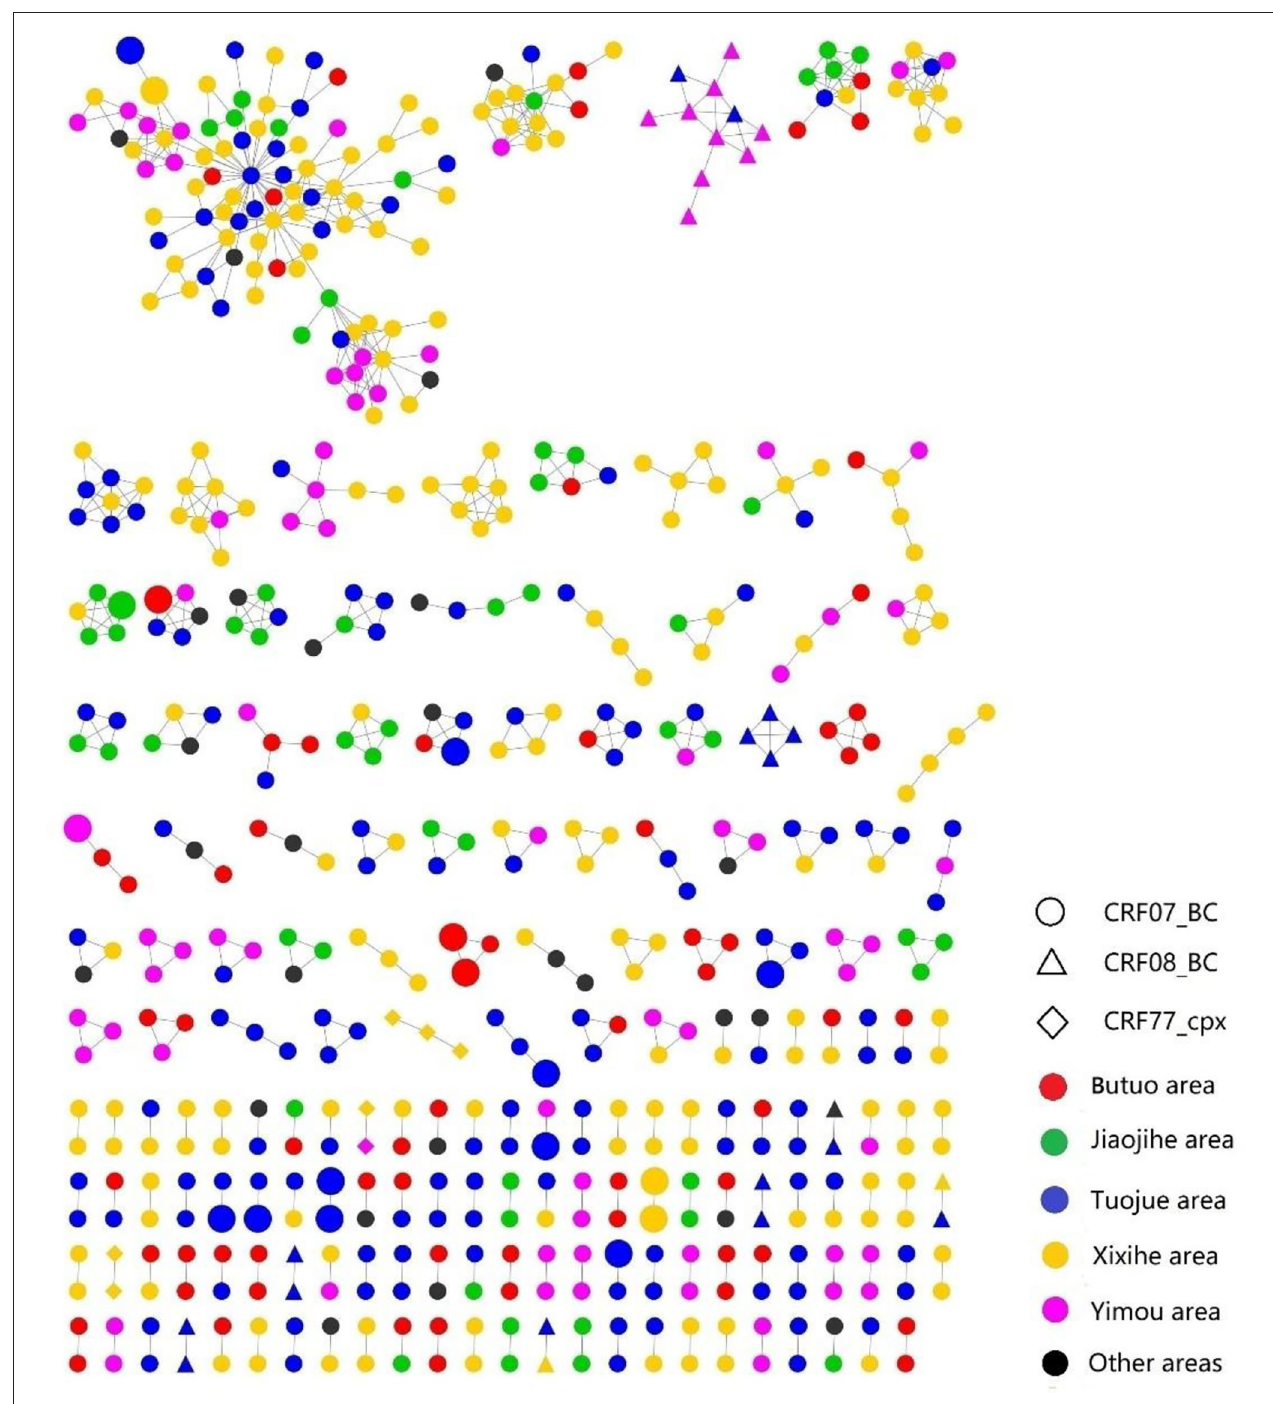
FIGURE 2 | The transmission networks of HIV-1 newly diagnosed PLWH by HIV-1 subtypes and locations; the large shapes represented recent infections within 130 days by LAg EIA.